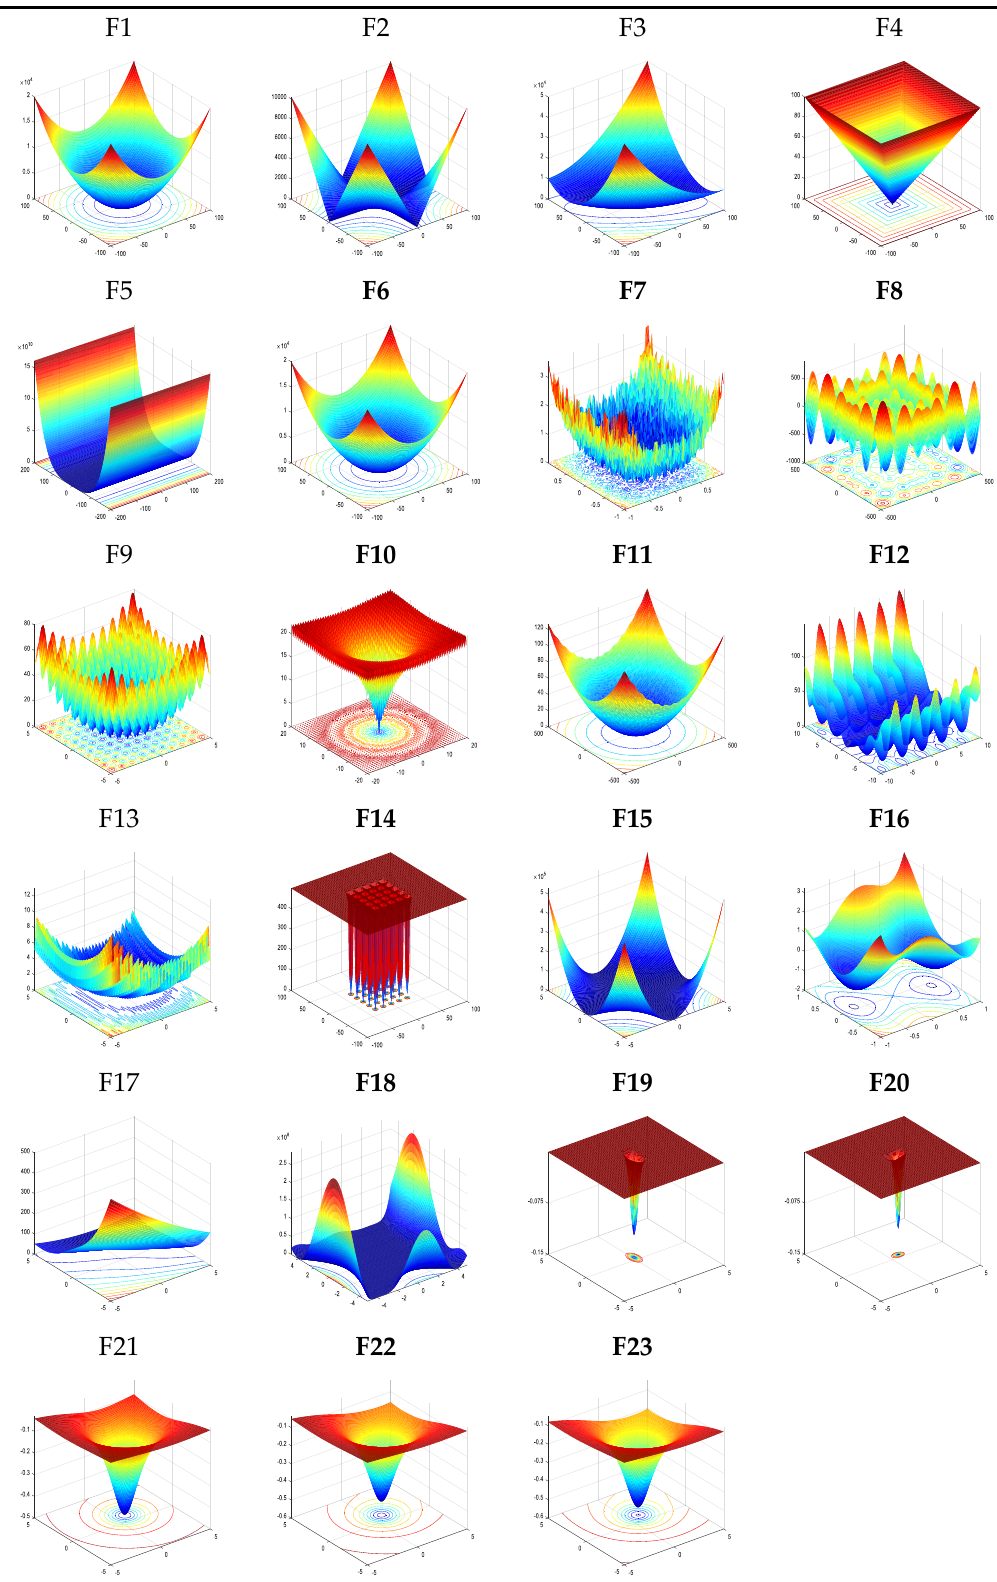
Table 9. 3D Surface Plots of the Benchmark Functions F1–F23.